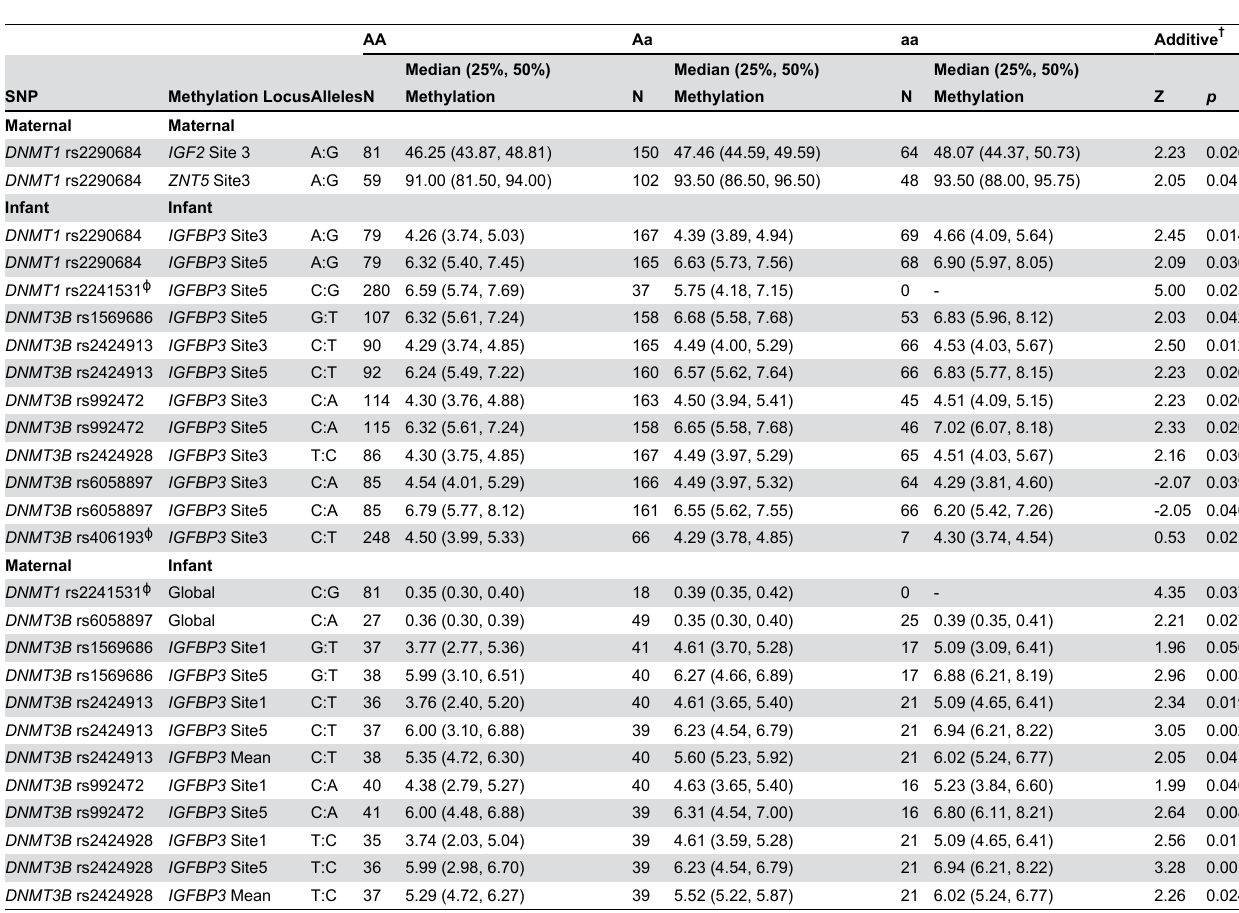
Table 2. Significant associations between methylation and genetic